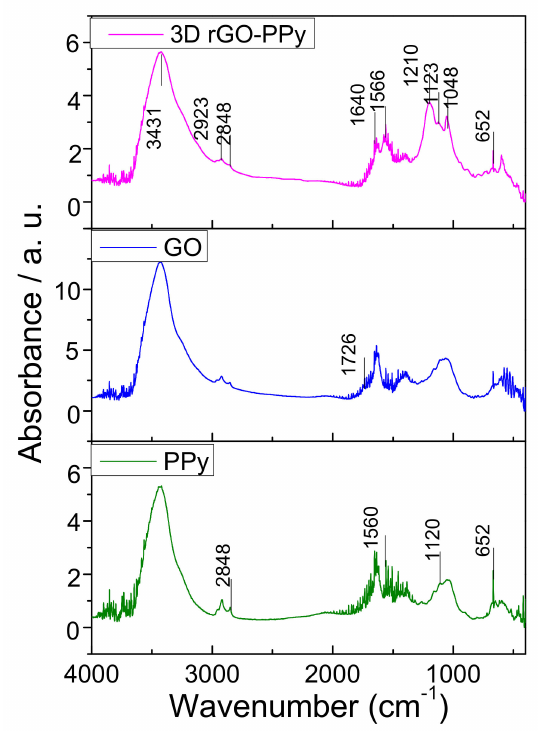
Figure 6. Fourier-transform infrared spectroscopy (FTIR) spectra of PPy, GO and 3D